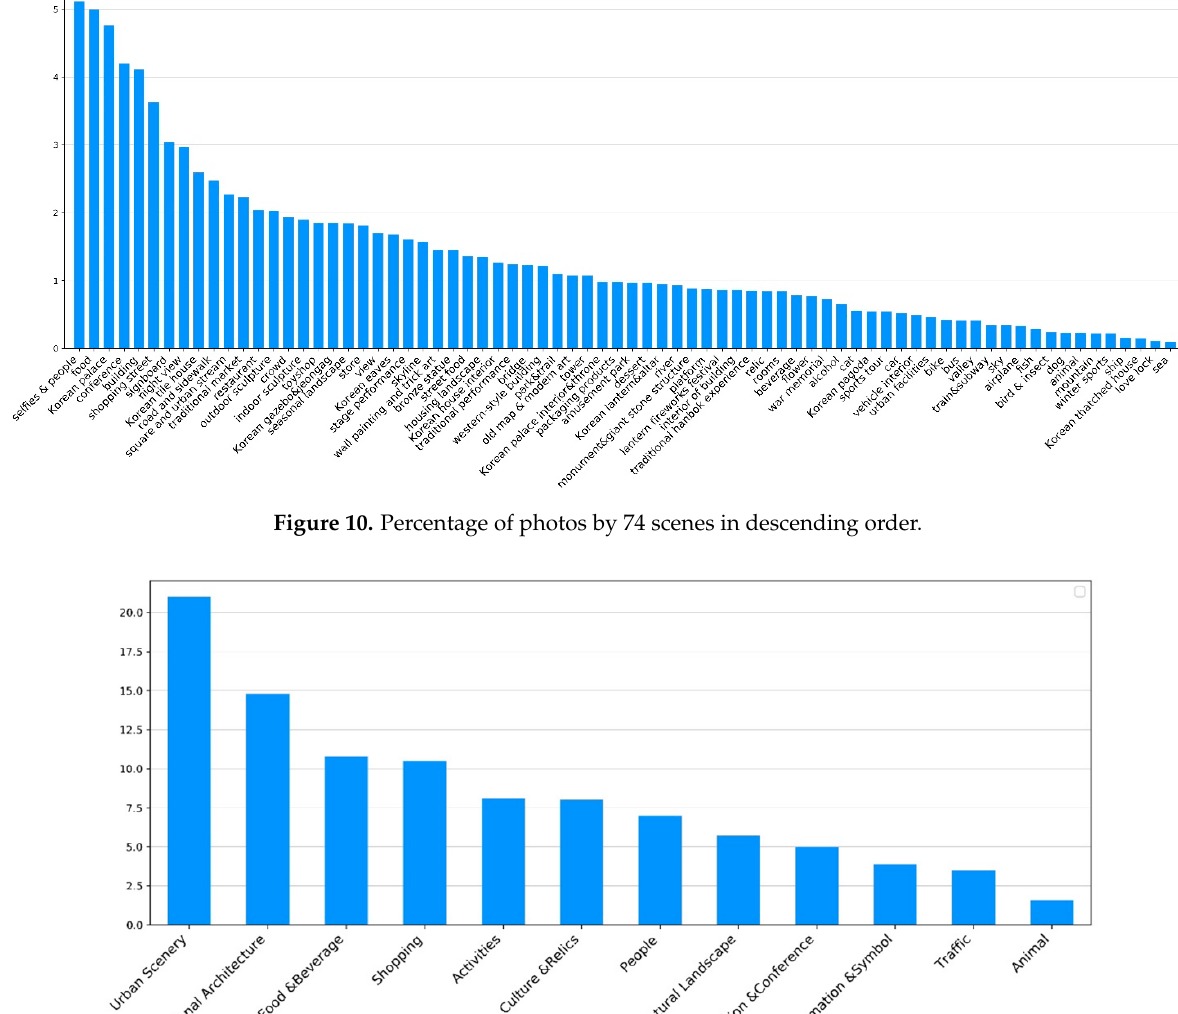
Figure 12. Kernel density map of tourist photos: ( a ) dot map; and ( b ) kernel density map. However, the clustered areas in Seoul appear differently by category. Figure 13 shows the kernel density map by grouping 74 scenes into 12 categories. The kernel density map can be classified into three types. The first type is a category in which one distinct core region appears and the spread to other regions is weak. The “shopping”, “Korean traditional architecture”, and “information and symbol” categories belong to this type. For example, Myeong-dong is a hot spot for shopping, while Gyeongbokgung Palace and Gwanghwamun Gate are the bustling places for Korean traditional architecture. The second type is a type in which small dense areas are scattered in various places in addition to the city center. The “food and beverage”, “people”, “culture and relics”, and “traffic” categories belong to this type. For the categories of “food and beverage” and “people”, frequently visited regions at a small scale can be found in places around Shinchon-Hongdae, Itaewon, and Garosu-gil in Gangnam. For the “culture and relics” category, frequently visited places at a small scale are found in Namsan Tower, as well as Gyeongbokgung Palace, Gwanghwamun Gate, and Jongro, surrounding areas of the War